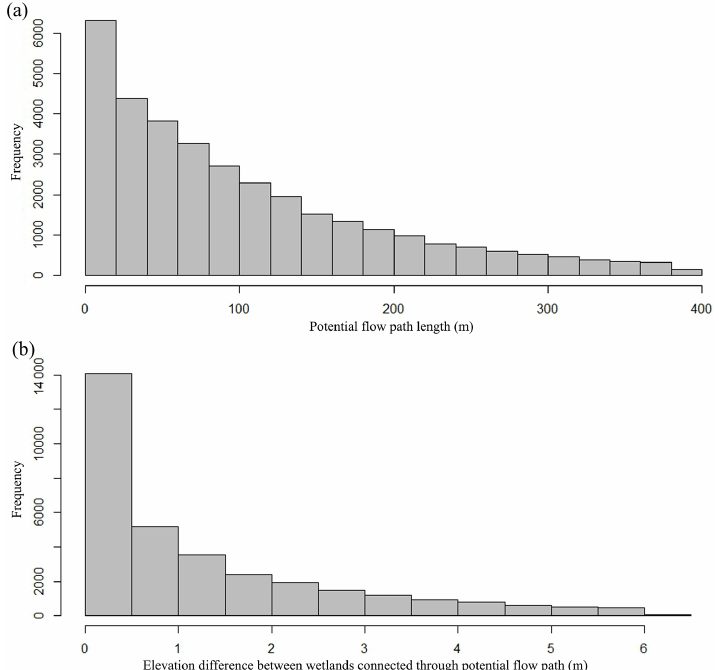
Figure 10. Histogram of potential wetland connectivity. (a) Potential flow path lengths; (b) elevation differences between wetlands connected through potential flow